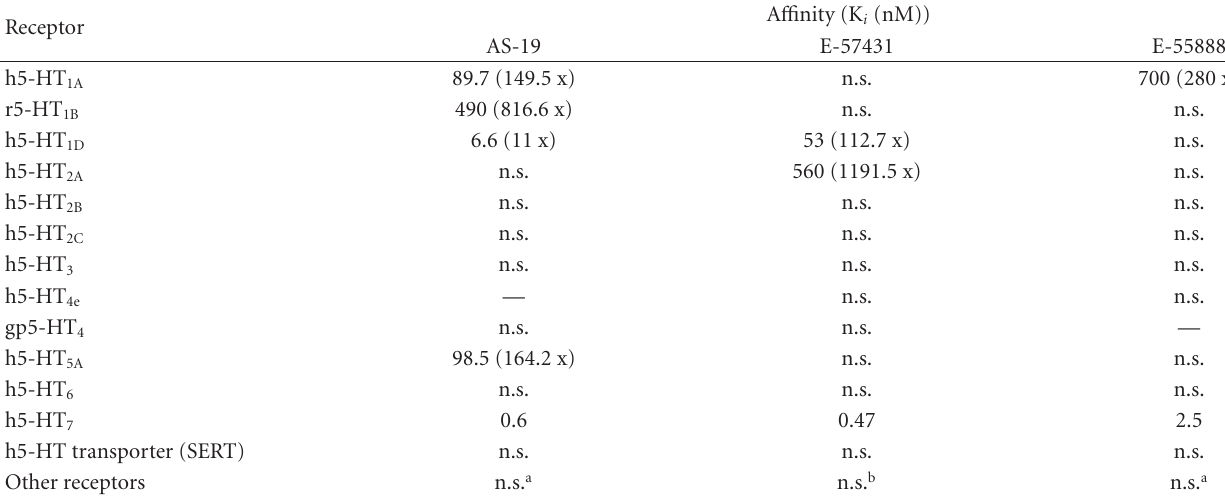
Table 1: Binding profiles of the 5-HT 7 receptor agonists AS-19, E-57431, and E-55888.